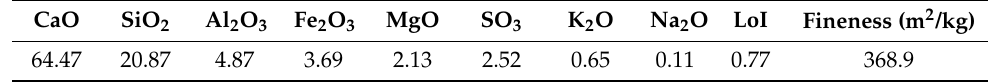
Table 1. Chemical composition (% by mass) and fineness of the cement.